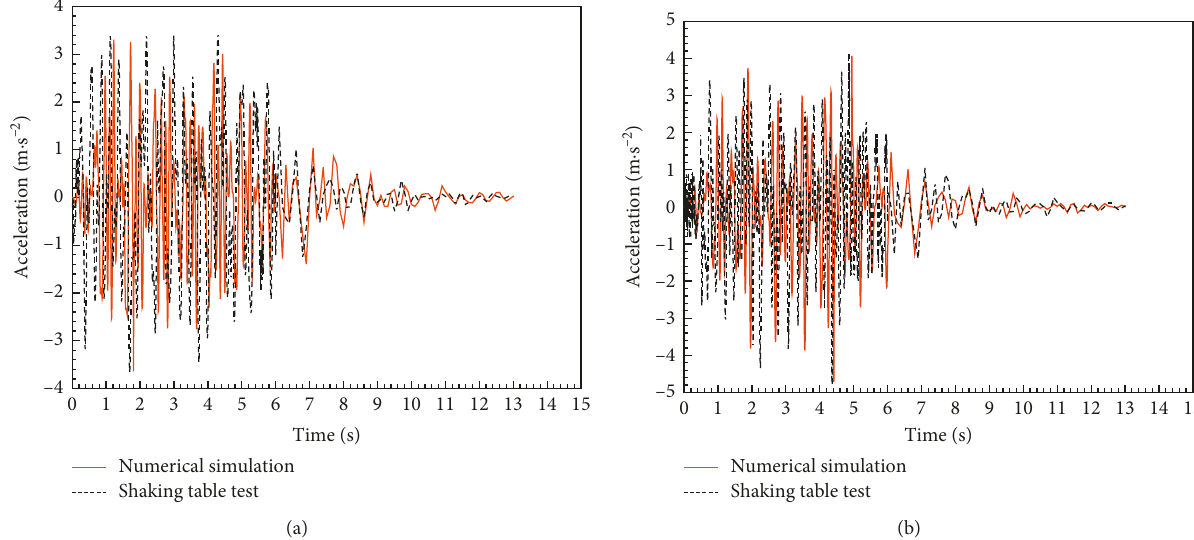
Figure 5: Time history curves of numerical simulation and shaking table test. (a) Horizontal direction. (b) Vertical direction. Table 2: Comparison of acceleration response peak value (unit: 2 ). m s · − Numerical simulation